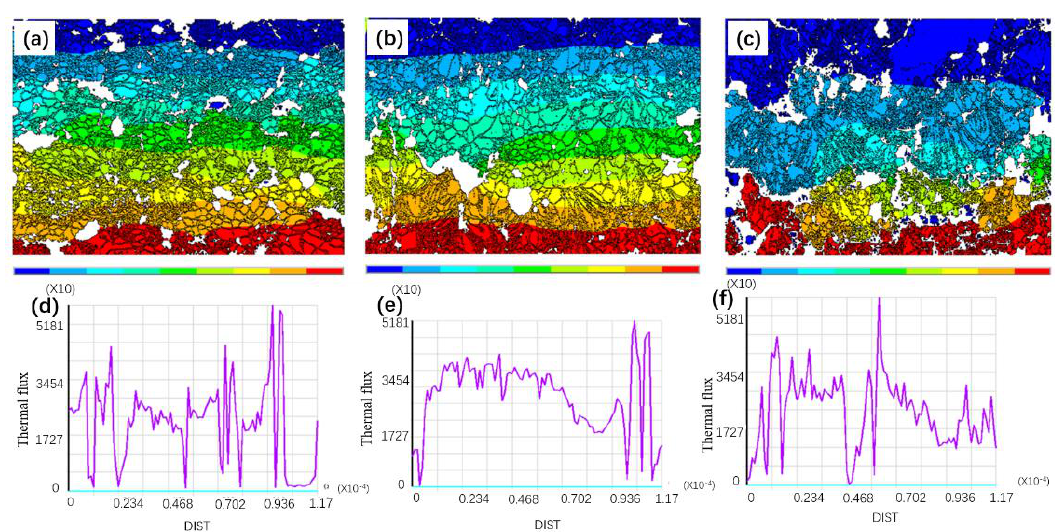
Figure 3. Distributions of thermal gradient ( a ) M 1 , ( b ) M 2 and ( c ) M 3 , and the thermal flux of coatings: ( d ) M 1 , ( e ) M 2 and ( f ) M 3 . Table 4. The comparison of theoretical results λ s and experimental results λ 0 .